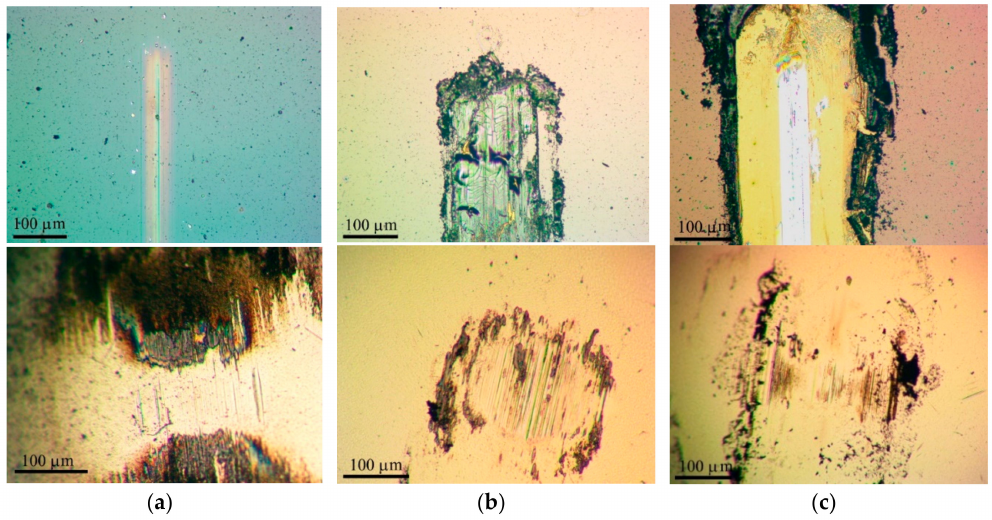
Figure 13. Optical images of wear tracks and wear scars formed on the steel substrates and steel balls for the Mo-S-C-H thin-film coatings obtained by reactive PLD at the di ff erent pressures of H 2 S gas: ( a ) 5.5, ( b ) 9, and ( c ) 18 Pa. Pin-on-disk tribometer testing was conducted in dry friction conditions at − 100 ◦ C. The test durations are indicated in Figure